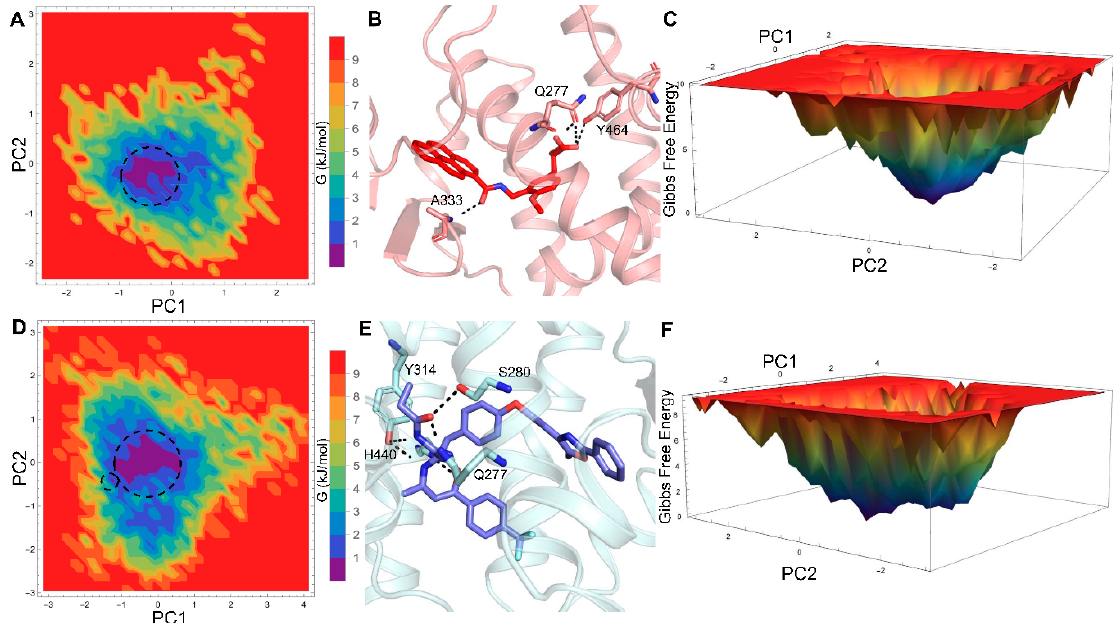
Figure 5. 2D-FEL of agonist- ( A and C ) and antagonist-bound ( D and F ) forms of PPAR- α displayed as a function of two principal components, whose cosine contents were less than 0.2. The representative structures of agonist- ( B ) and antagonist-bound ( E ) forms with minimal energy are zoomed out to show the residues critical for ligand binding. The residues important for ligand recognition are shown as red and slate blue colored sticks and the H-bonds are displayed as black dashed lines. The minimal energy clusters are highlighted using black dotted circles.